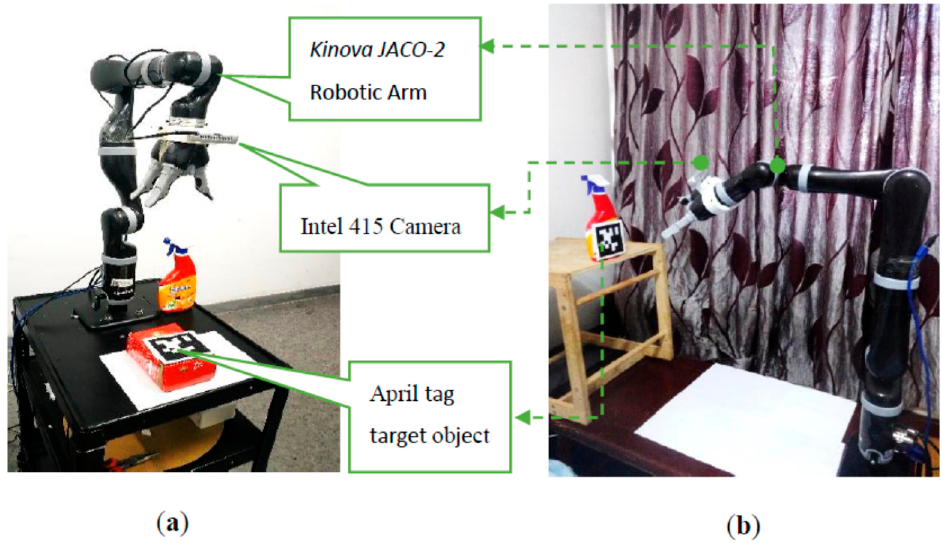
Figure 7. Experimental setup for mix frame IBVS framework using Kinova ® 7 DOF robotic arm, Intel D415 camera, April tag target ( a ) lab environment ( b ) home environment.